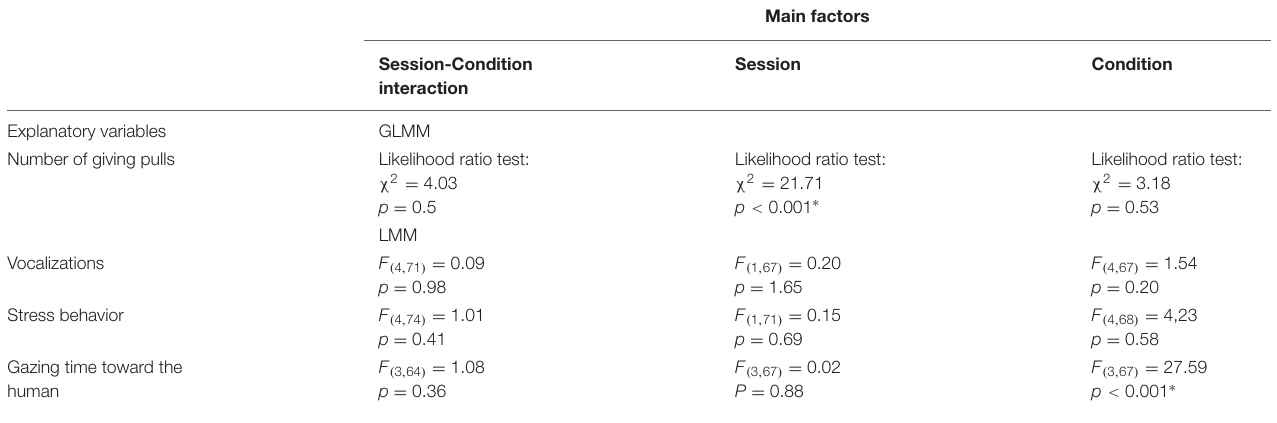
TABLE 1 | Likelihood ratio test of the GLMM models and ANOVA output of the LMM